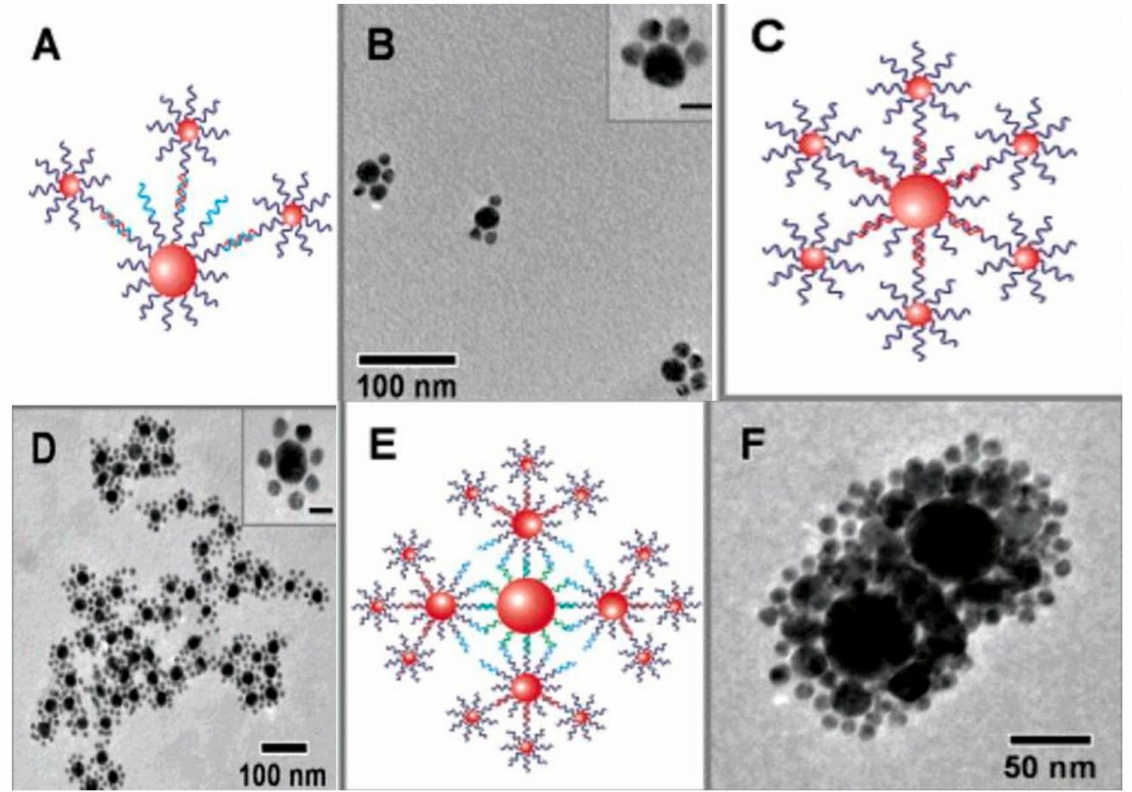
Figure 49. Directional assembly of the dendrimer-like structures of asymmetrically functional Au NPs ( A , B ) cat paw ( C – F ). Installation: bar scale) 20 nm. Copyright 2017 RSC, re-printed with reference permission